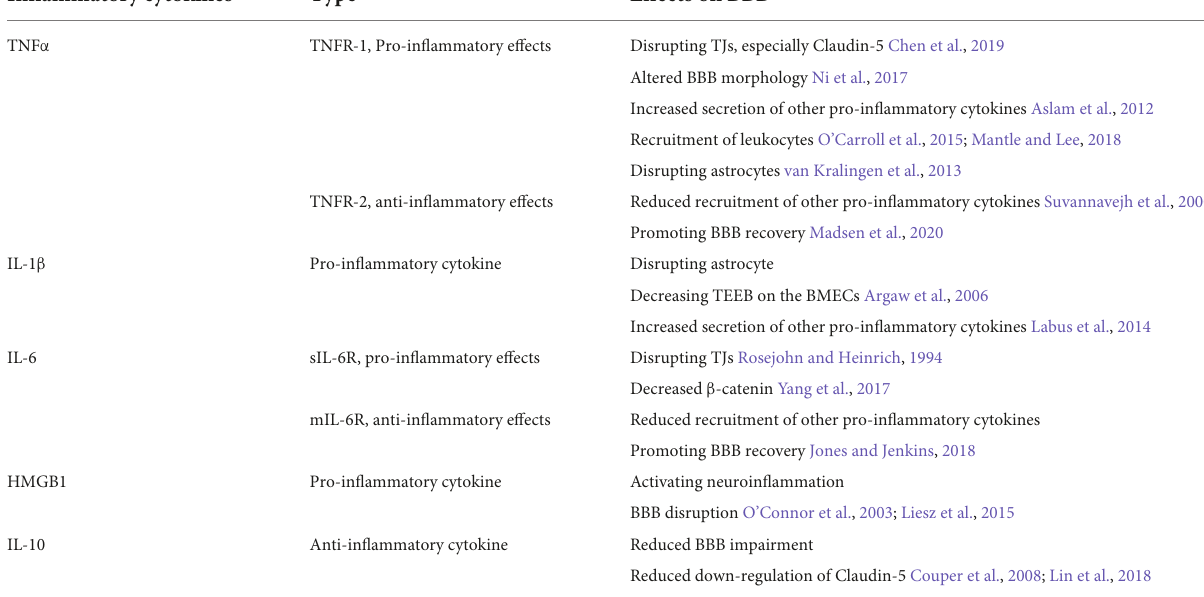
TABLE 1 Interaction between inflammatory cytokines and the